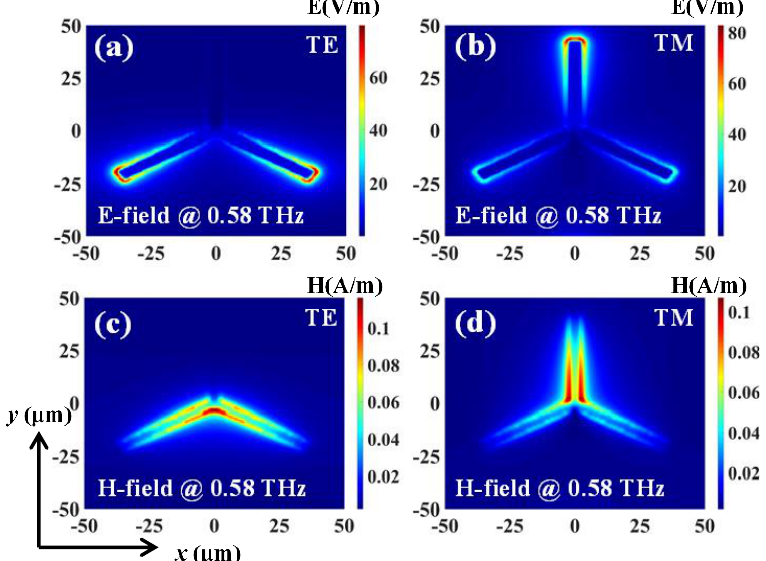
Figure 2. Electromagnetic responses of the triadius structure by changing the L parameter in ( a ) TE and ( b ) TM modes.